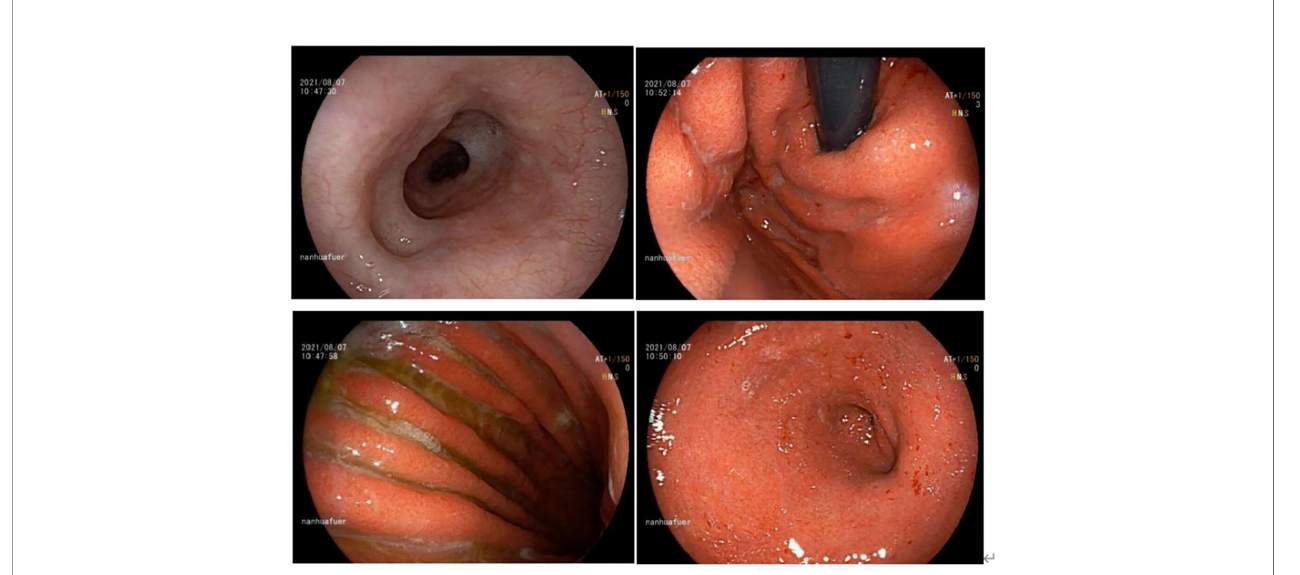
FIGURE 4 | Gastroscopy of acute erosive hemorrhagic gastritis after steriod treatment (day 526) showed marked improvements. The esophageal mucosa was smooth with good contraction. The whole gastric mucosa was hyperemic and edematous, with scattered fl aky erosion (particularly in the gastric antrum) and partial bleeding. The gastric mucosa showed yellow – green bile and some white opaque mucus. Compared with the previous EGD fi ndings, the mucosa as seen in this EGD was basically healed.